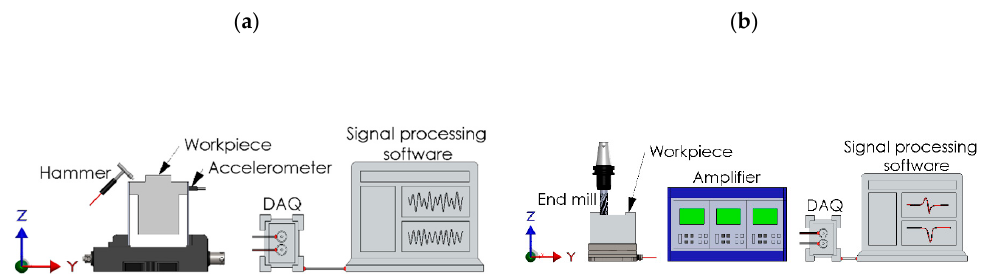
Figure 5. Scheme of the experimental setup for ( a ) the modal analysis and ( b ) cutting forces characterization.